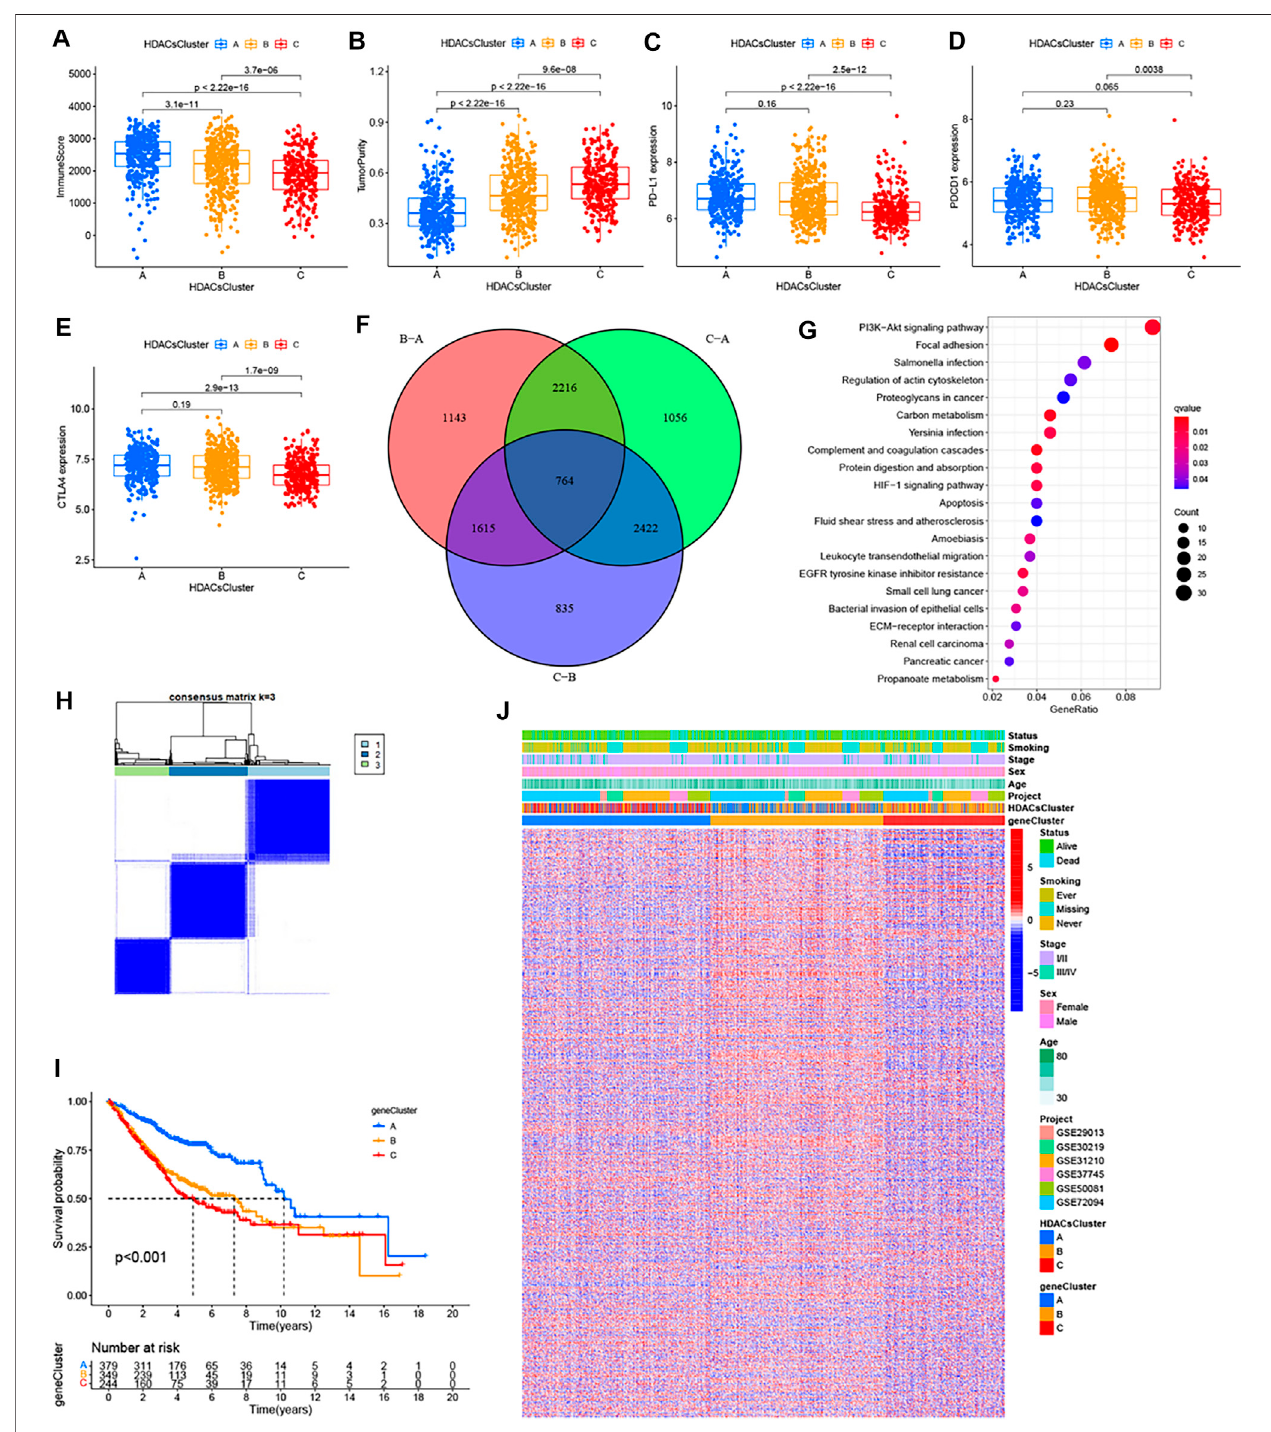
FIGURE 3 | Immune landscapes among the three distinct molecular subtypes and HDAC phenotype – related reclustering. (A) Immune score, (B) tumor purity, (C) PD-L1 expression, (D) PDCD1 expression, and (E) CTLA-4 expression differences in three distinct molecular subtypes. (F) 764 HDAC phenotype – related differentially expressedgenes(DEGs)betweenthreedistinctmolecularsubtypeswereshownintheVenndiagram. (G) Functionalannotationforphenotype-relatedDEGsassociated with the prognosis using KEGG enrichment analysis. (H) Unsupervised clustering of the HDAC phenotype – related genes and consensus matrices for k = 3. (I) Survival curves of the HDAC phenotype – related gene signatures were estimated by the Kaplan − Meier plotter. (J) Unsupervised clustering of HDAC phenotype – related DEGs. The geneCluster, HDACsCluster, project, age, sex, stage, smoking status, and survival status were used as patient annotations. Red represented high expression of regulators and green represented low